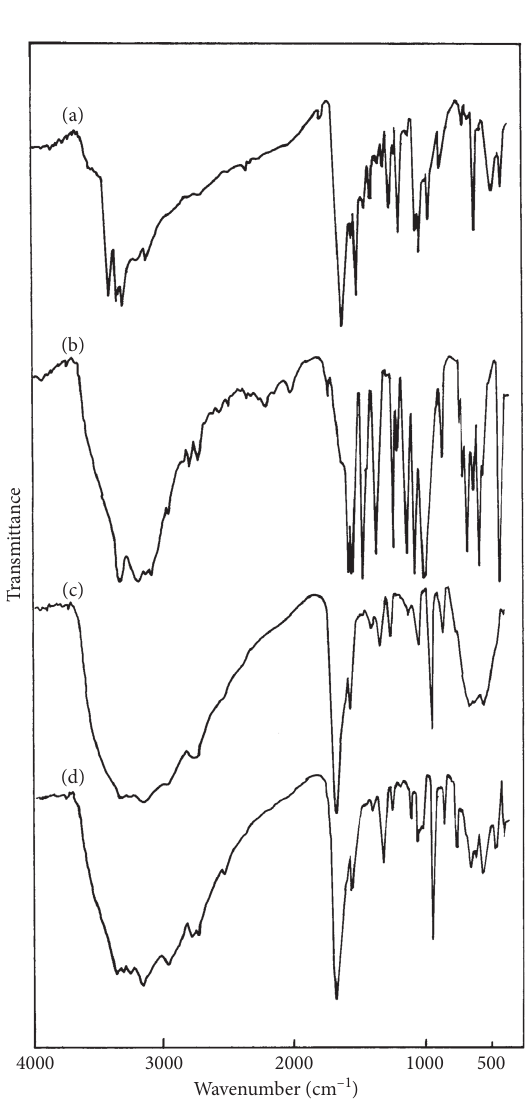
Figure 3: Infrared spectra for (a) CdCl 2 -(3amt), (b) CdCl 2 -2(3amt), (c) SnCl 2 -(3amt).H 2 O, and (d) SnCl 2 -2(3amt).H 2